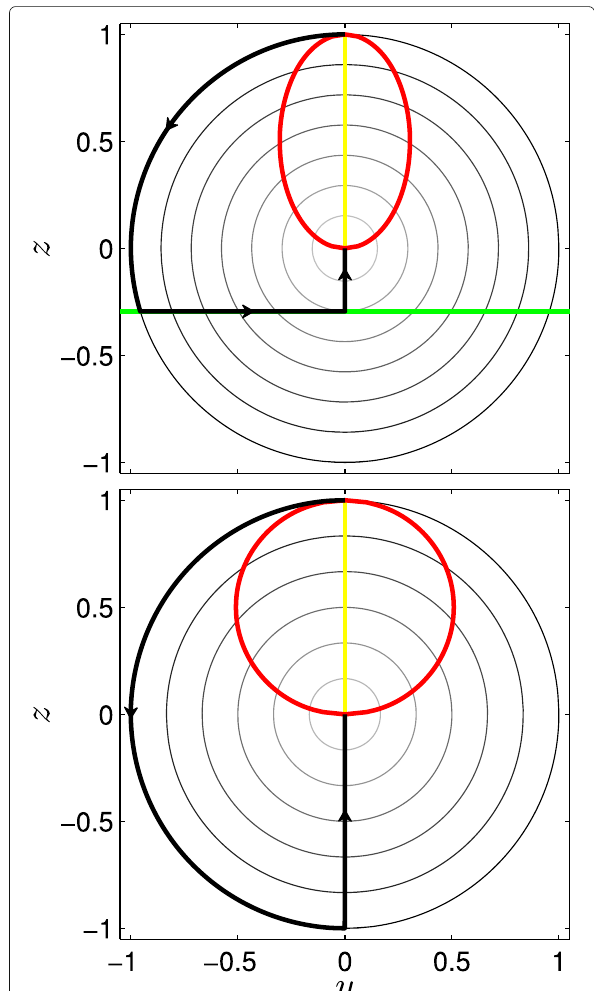
Fig. 3 (Color online) Time-optimal trajectory to reach the center of the Bloch ball ( y , z ) = ( 0,0 ) from the north pole